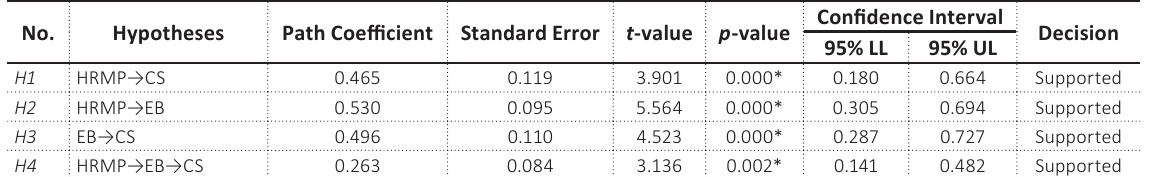
Table 5. Hypotheses testing